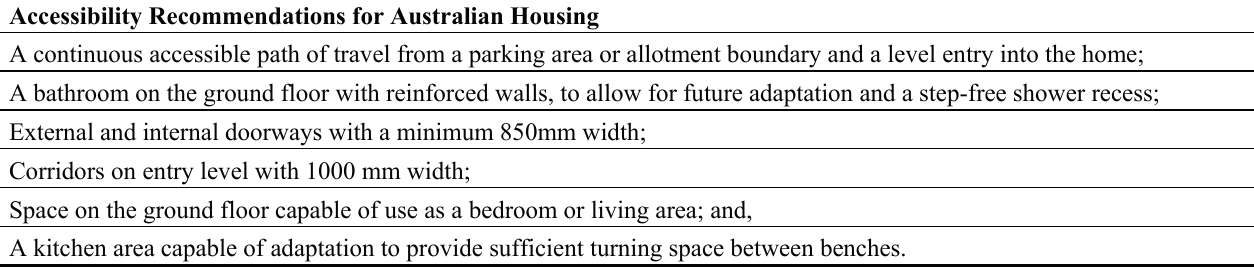
Table 2. Minimum Access Requirements Recommended for Australian Private